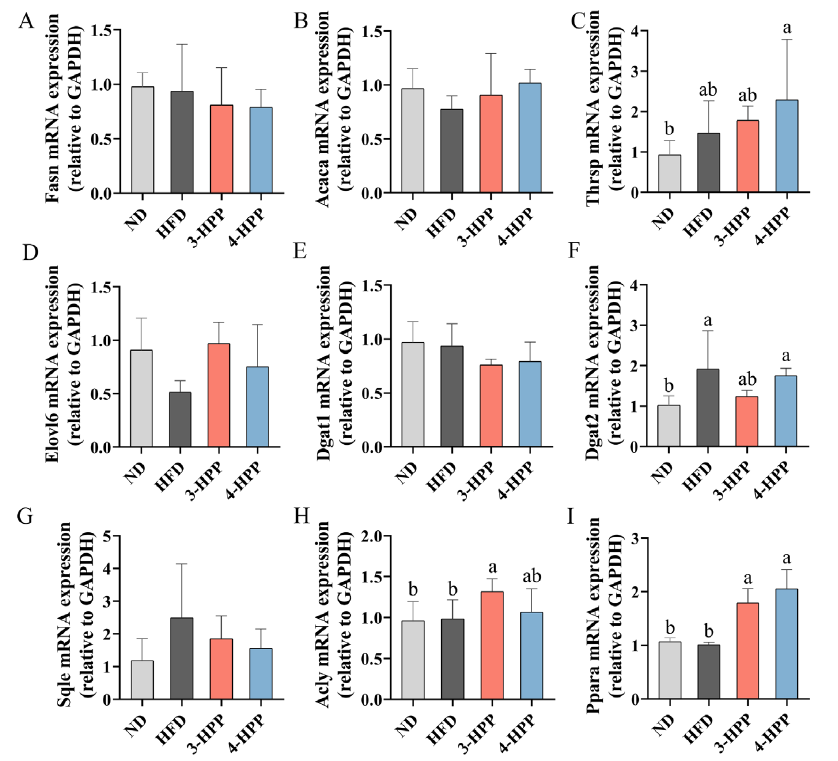
Figure 3. The impacts of 3 − HPP and 4 − HPP on gene expression of hepatic lipid metabolism. mRNA expression of ( A ) Fasn, ( B ) Acaca, ( C ) Thrsp, ( D ) Elovl6, ( E ) Dgat1, ( F ) Dgat2, ( G ) Sqle, ( H ) Acly, and ( I ) Ppara in liver. Data are shown as the mean ± SD. n = 6 if not specified. According to Duncan’s test, mean values with different letters mean significant differences at p < 0.05.